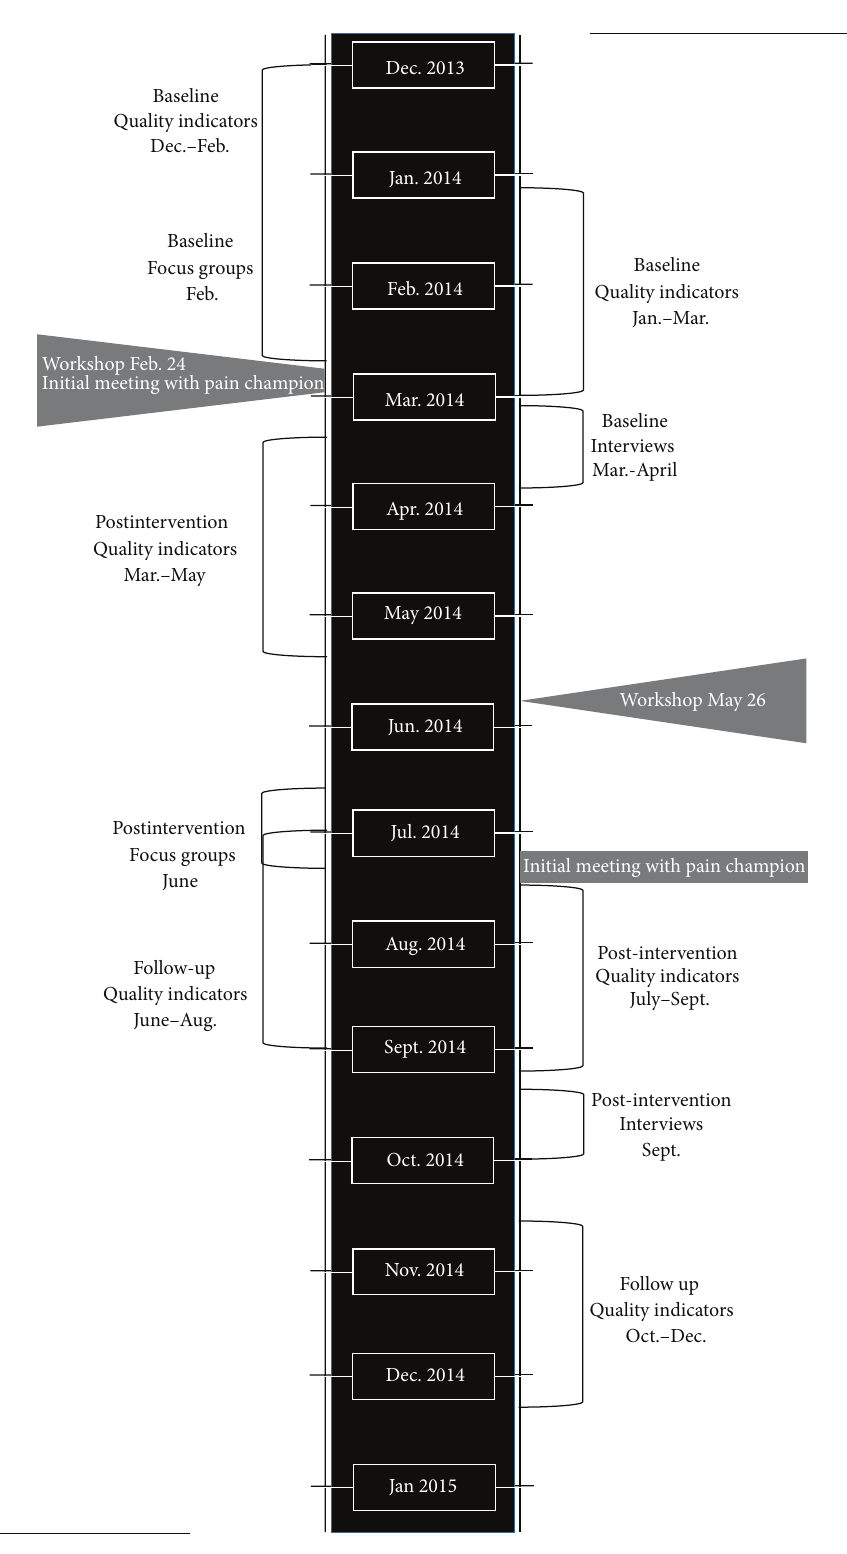
Figure 1: Timeline of implementation